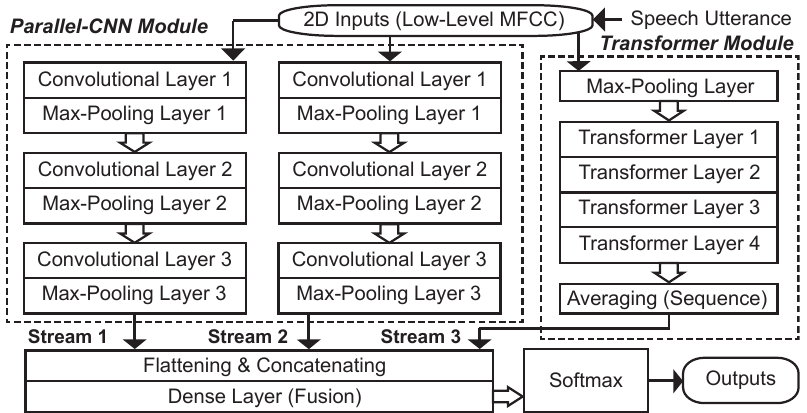
Figure 1. A systematic overview of the proposed TCC in this work for depression detection in speech, including the parallel-CNN and transformer